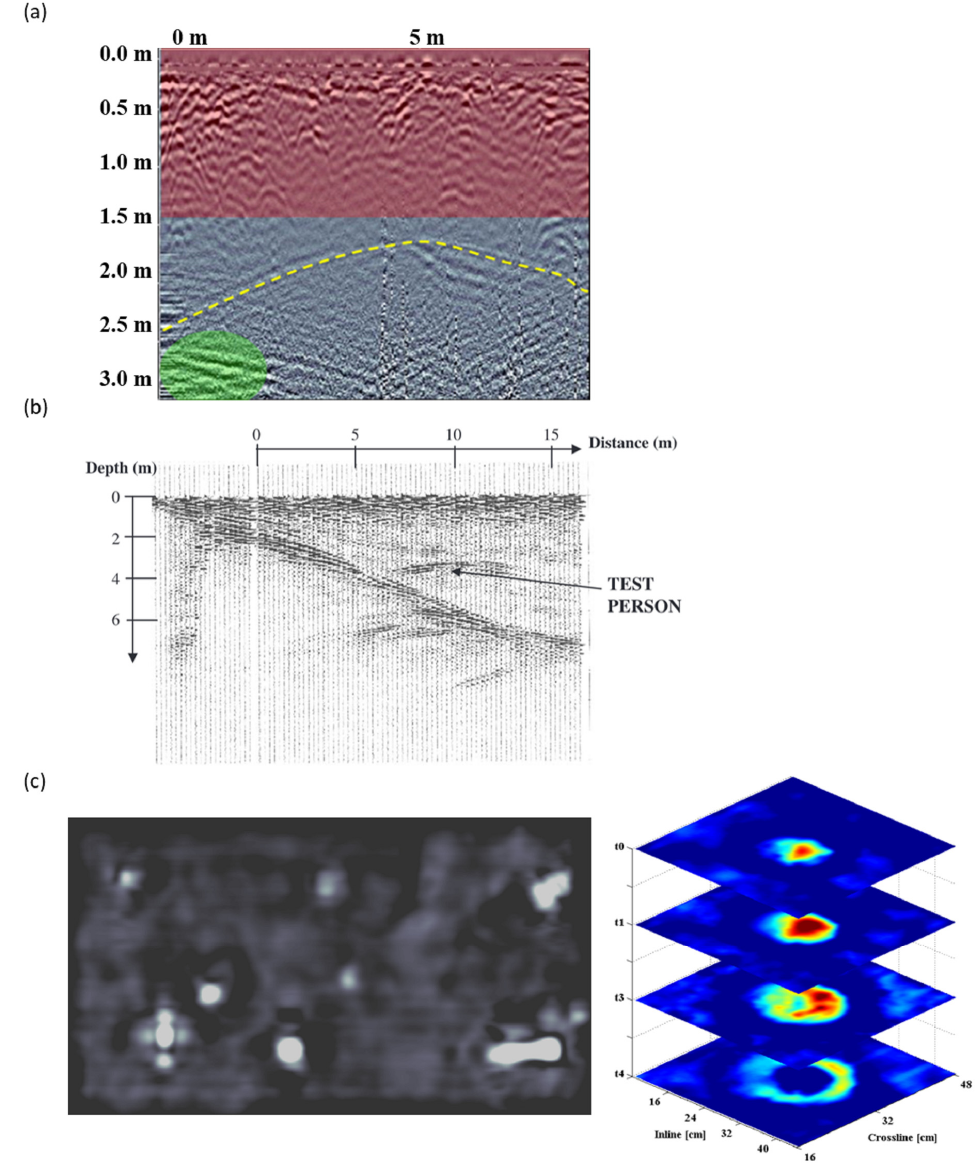
Figure 3. Examples of GPR application in forensic and demining contexts. ( a ) A 500 MHz radargram acquired over the potential location of a missing person (green shadow). ( b ) A 900 MHz radargram showing an example of a cave with a test person. ( c ) Depth slice of a 2 GHz 3D acquisition over a test minefield including inert landmines, mortar shells and rocks. From the same survey, Set of 2 GHz slices of an antipersonnel landmine showing the presence of an internal structure within the landmine volume. Adapted with permission from [122,135]. Copyright 2014, IEEE.